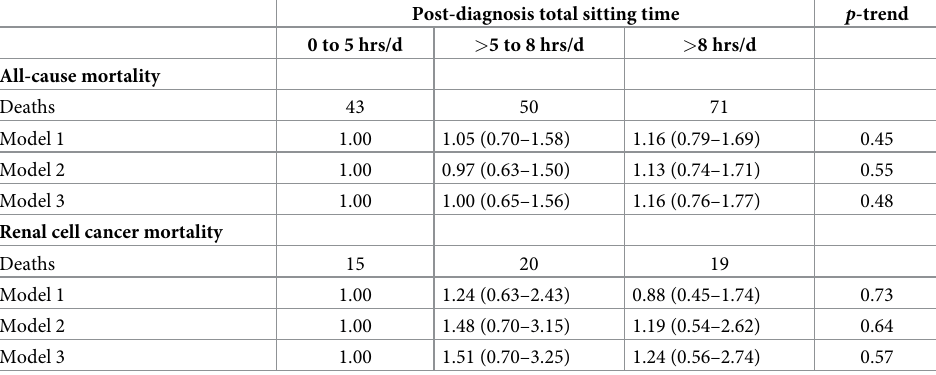
Table 4. Hazard ratios and 95% confidence intervals of mortality among individuals diagnosed with renal cell cancer according to post-diagnosis total sitting time. Post-diagnosis total sitting time p -trend